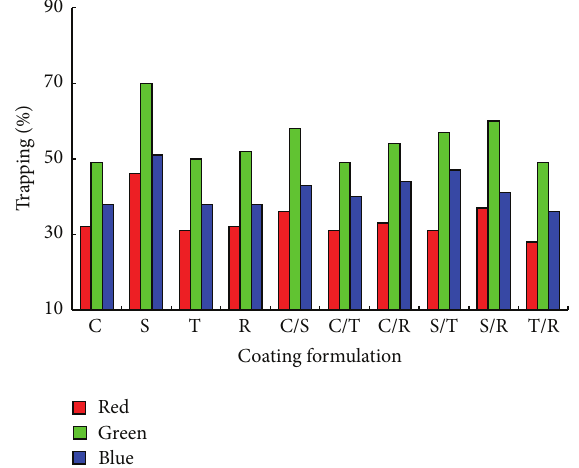
Figure 9: Effects of coating formulations on red, green, and blue (RGB) plate image trapping of color inkjet-printed paper. C: CaCO 3 ; S: SiO 2 ; T: talc; R: sericite, with mixing ratios of 50/50.